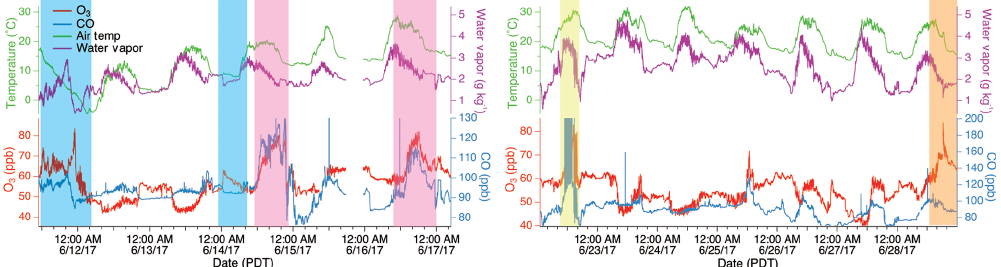
Figure 5. Time series of 1min averaged air temperature, water vapor, O 3 , and CO mixing ratios measured by the NOAA mobile lab deployed at Angel Peak during 11–16 June and 22–28 June 2017, highlighting the periods with stratospheric influence (blue), regional anthropogenic pollution plumes (pink), wildfire plumes (yellow), and the unattributed pollution plume (orange). Data are shown in Pacific daylight time (PDT). Note that peak CO mixing ratios on 22 June were 440ppbv (not shown on the